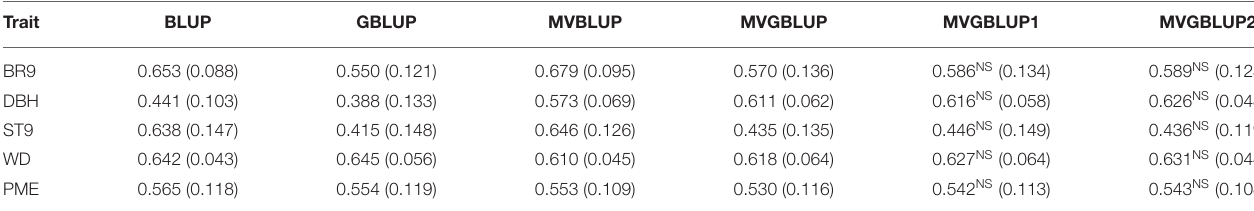
TABLE 4 | Prediction accuracies and their standard deviations (in parenthesis) obtained from multivariate mixed model in P. radiata population when using the documented pedigree (MVBLUP), a marker-based relationship matrix using all markers (MVGBLUP), a marker-based relationship matrix using selected SNPs having only